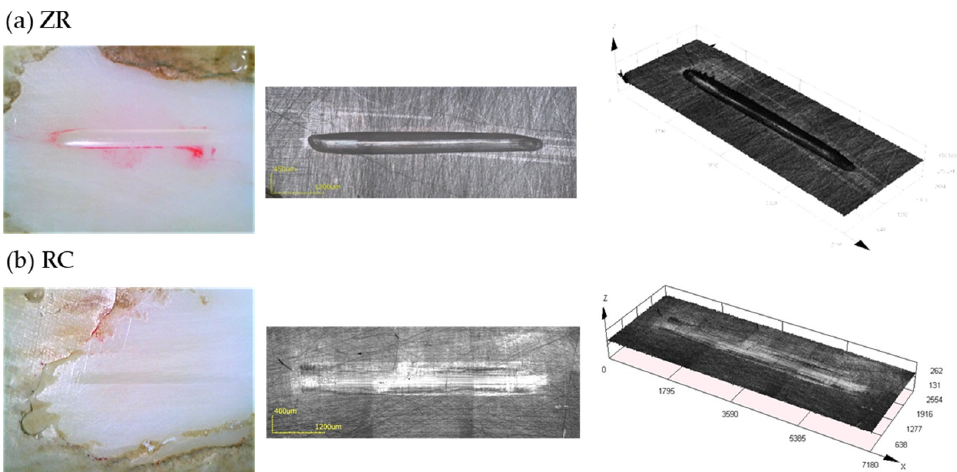
Figure 4. Digital microphotographs (left) and 3D laser microscope images (middle and right) of the substrate specimens after the wear test. Abbreviations of each experimental group are shown in